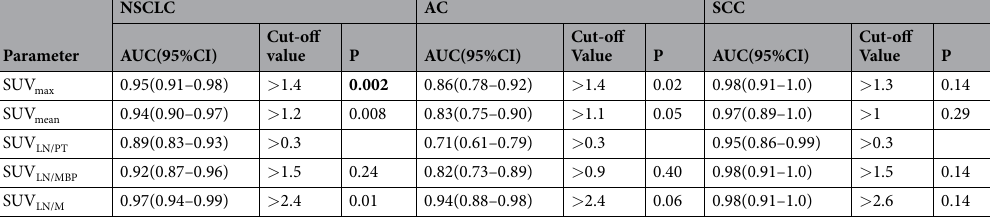
Table 2. Receiver operating characteristic analysis: area under the curves and optimal cut-off values. CI, confidence interval; SUV, standardized uptake value; LN, lymph node; MBPS, mediastinal blood pool; PT, primary tumor; M, muscle; P, P